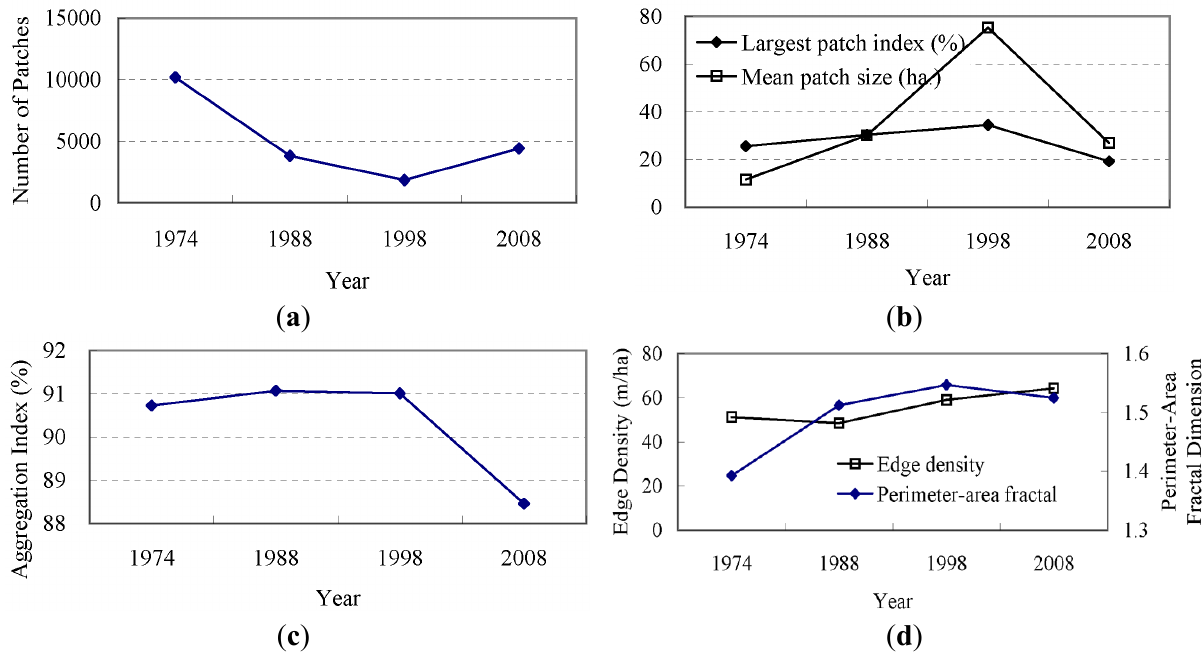
Figure 8. Dynamics of the landscape metrics of agricultural